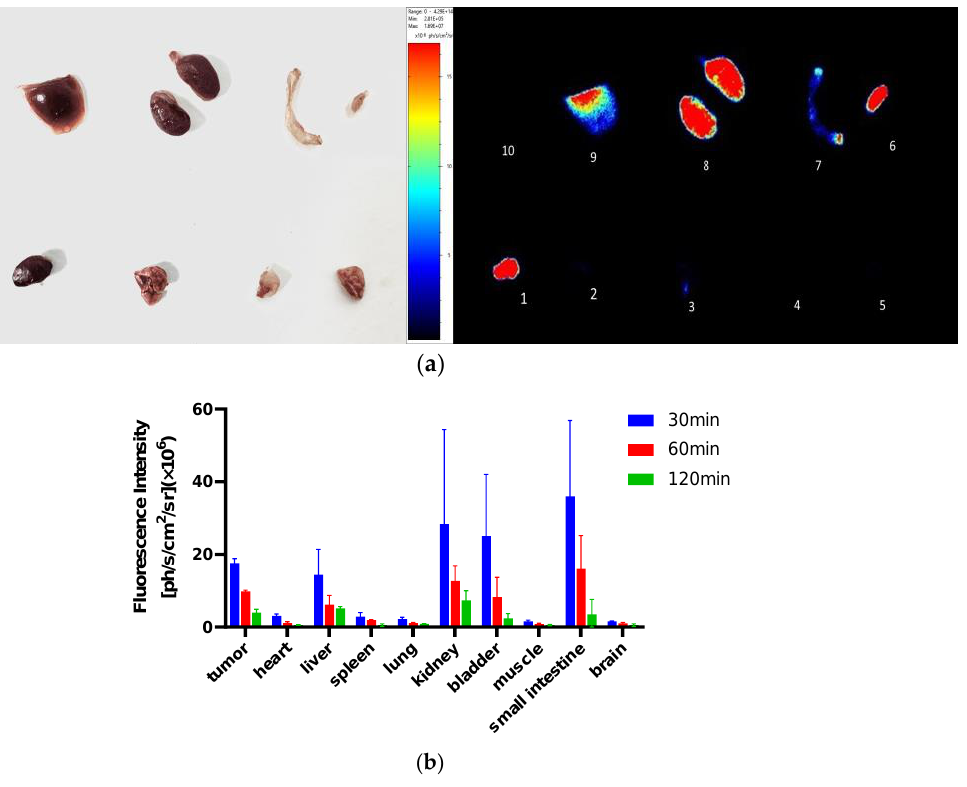
Figure 8. In vitro fluorescence imaging ( a ). Sixty minutes after the injection of PSMA-Cy5, the mice were euthanized and dissected for the in vitro imaging of tumors, tissues and organs; 1, tumor, 2, heart, 3, lung, 4, muscle, 5, brain, 6, bladder, 7, small intestine, 8, kidney, 9, liver, 10, spleen. ( b ) After injection of PSMA-Cy5, ROI analysis of the fluorescence intensity of the main tissues at 30 min, 60 min, and 120 min after injection was performed. Error bars are calculated as standard deviation (n = 3).